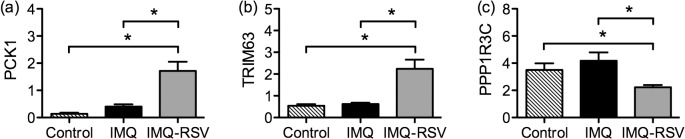
Quantitative PCR of microarray genes.Selected qPCR of genes that were 1.5 fold or more changed by RSV treatment in the microarray (RSV treated compared with the IMQ group). The mRNA levels were quantified using MYO18B as reference gene. (a) Phosphoenolpyruvate Carboxykinase 1 (PCK1). (b) Tripartite Motif Containing 63, E3 Ubiquitin Protein Ligase (TRIM63). (c) Protein Phosphatase 1, Regulatory (inhibitor) Subunit 3C (PPP1R3C). Columns in (a-c) are group means ±SEM (n = 8, n = 10, n = 10 for controls, IMQ, IMQ-RSV respectively). Clamped bar with * above indicates the pair of column means are significantly different (p<0.05).(Symbols: Striped fill = control, black fill = IMQ, grey fill = IMQ-RSV).